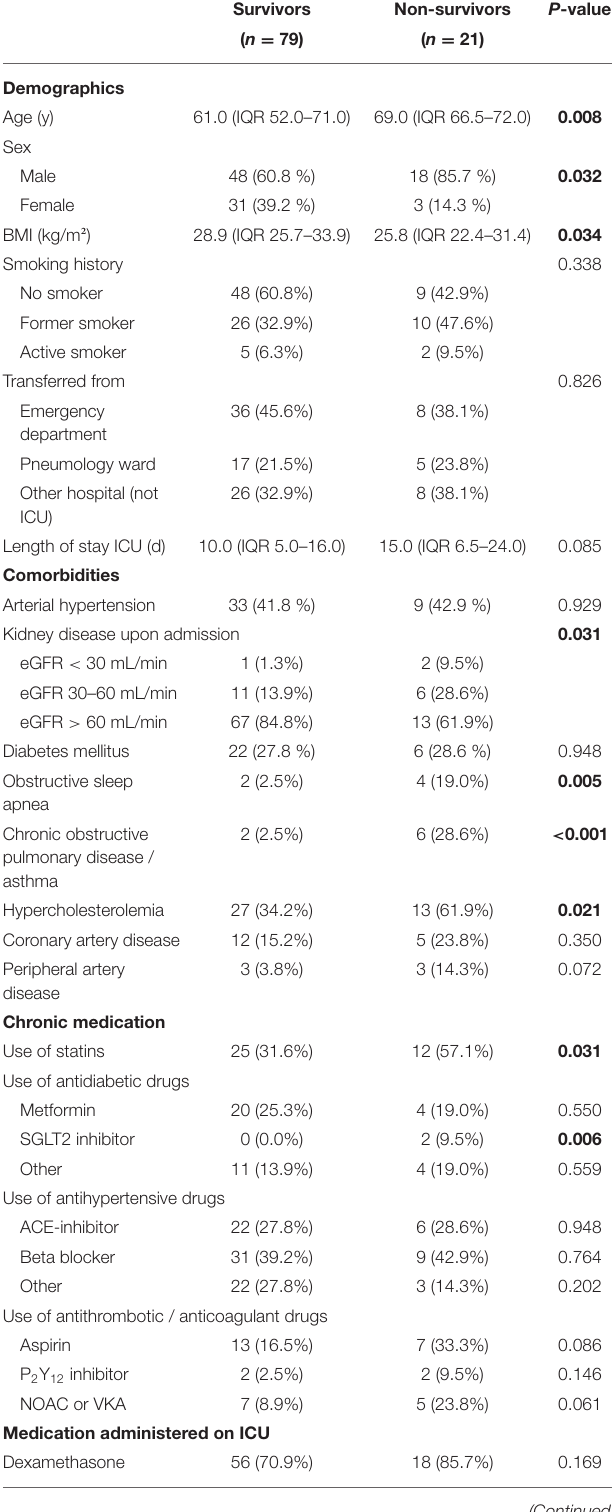
TABLE 2 | Distribution of baseline demographics, disease severity, laboratory assessments, and echocardiographic parameters of patients between survivors and